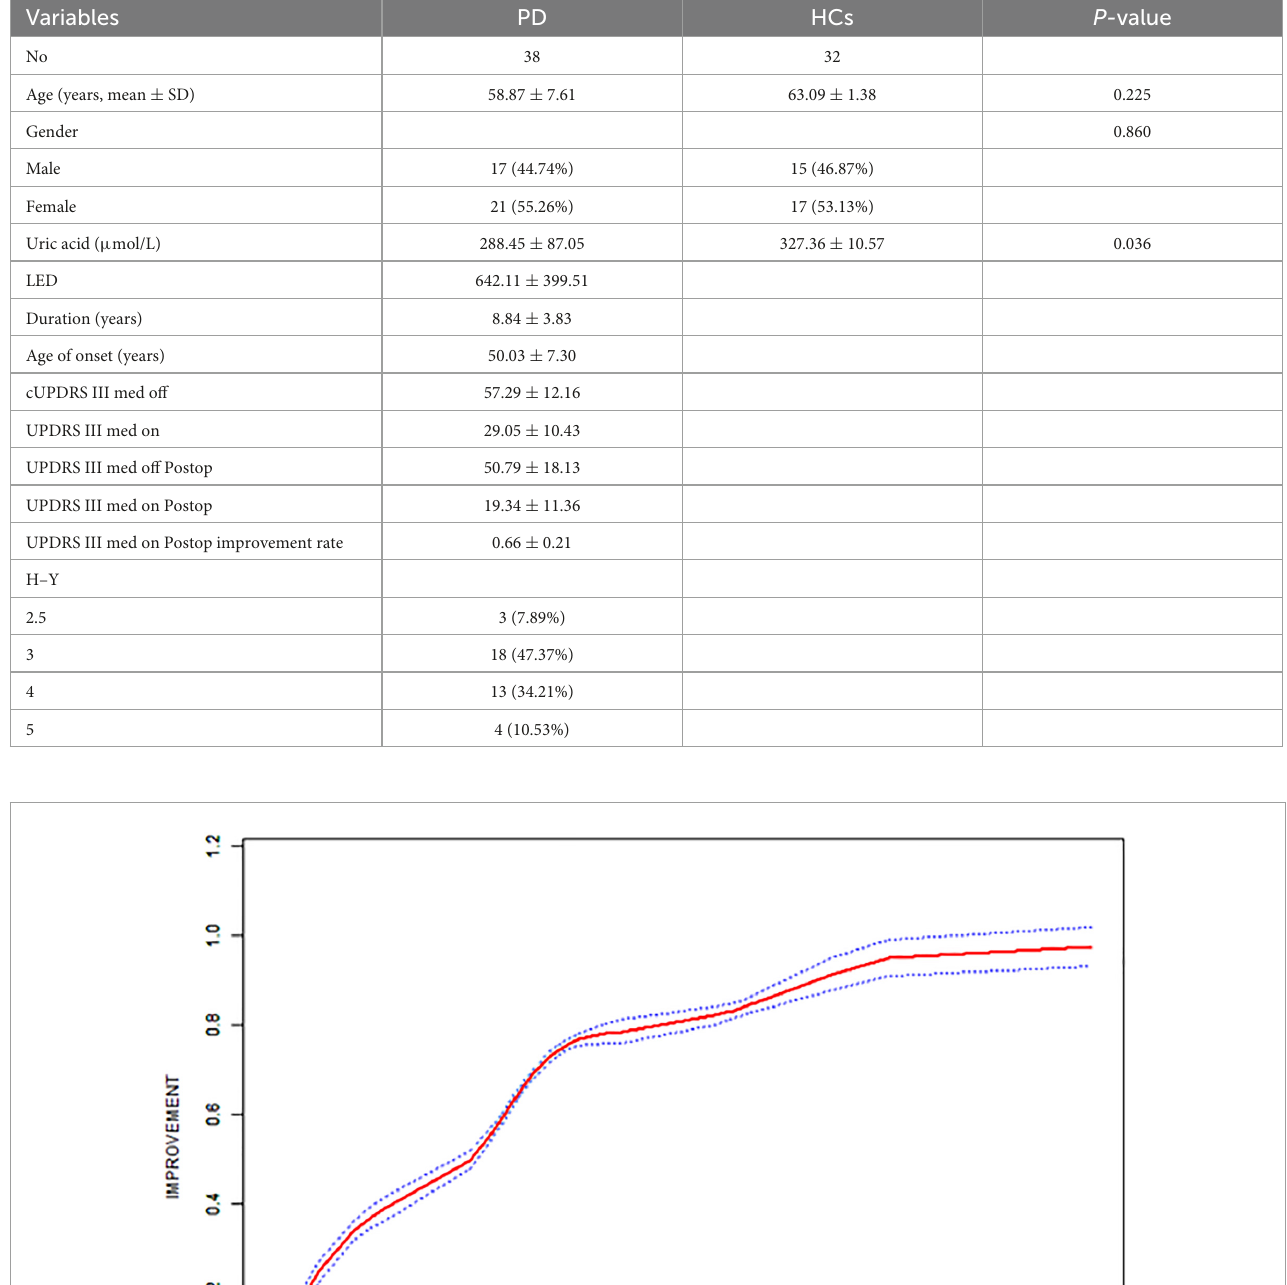
was 288.45 ± 87.05 µ mol/L 5 days prior to STN-DBS. Thirty-two healthy participants were included in the analysis. The median age of the healthy participants was 63 years (range: 44–75 years), and